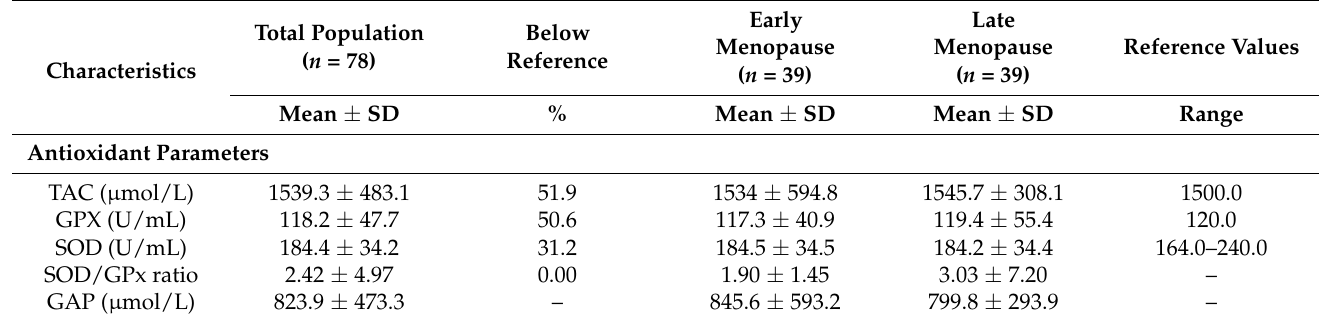
Table 2. Antioxidant status variables of the study.